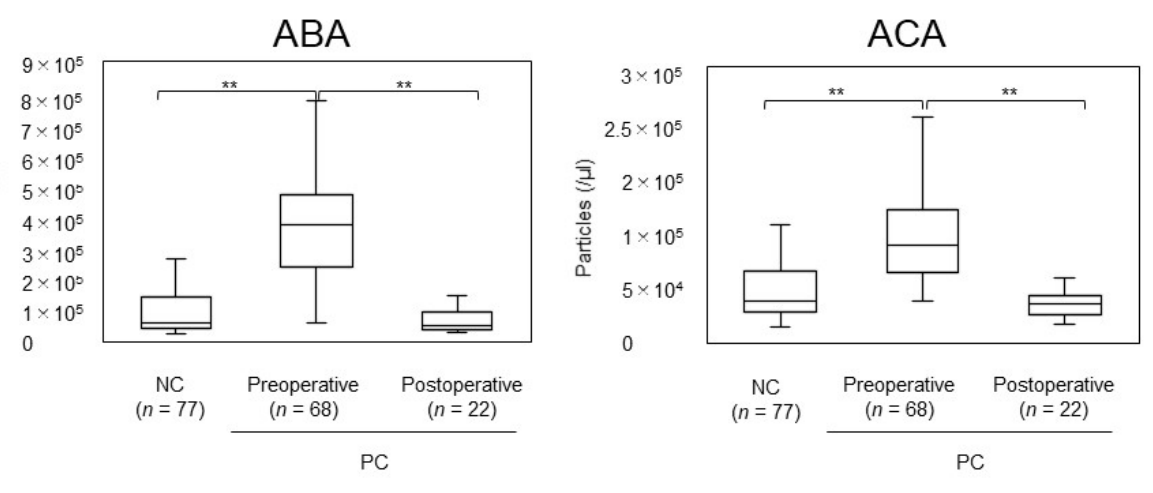
Figure 3. Quantification of ABA- and ACA-positive EVs from the sera of preoperative and postop- erative pancreatic cancer patients and negative controls. Patient sera were analyzed using ABA- or ACA-coated discs and anti-CD9 Ab-conjugated beads with ExoCounter. Adapted from Yokose et al. ** p <